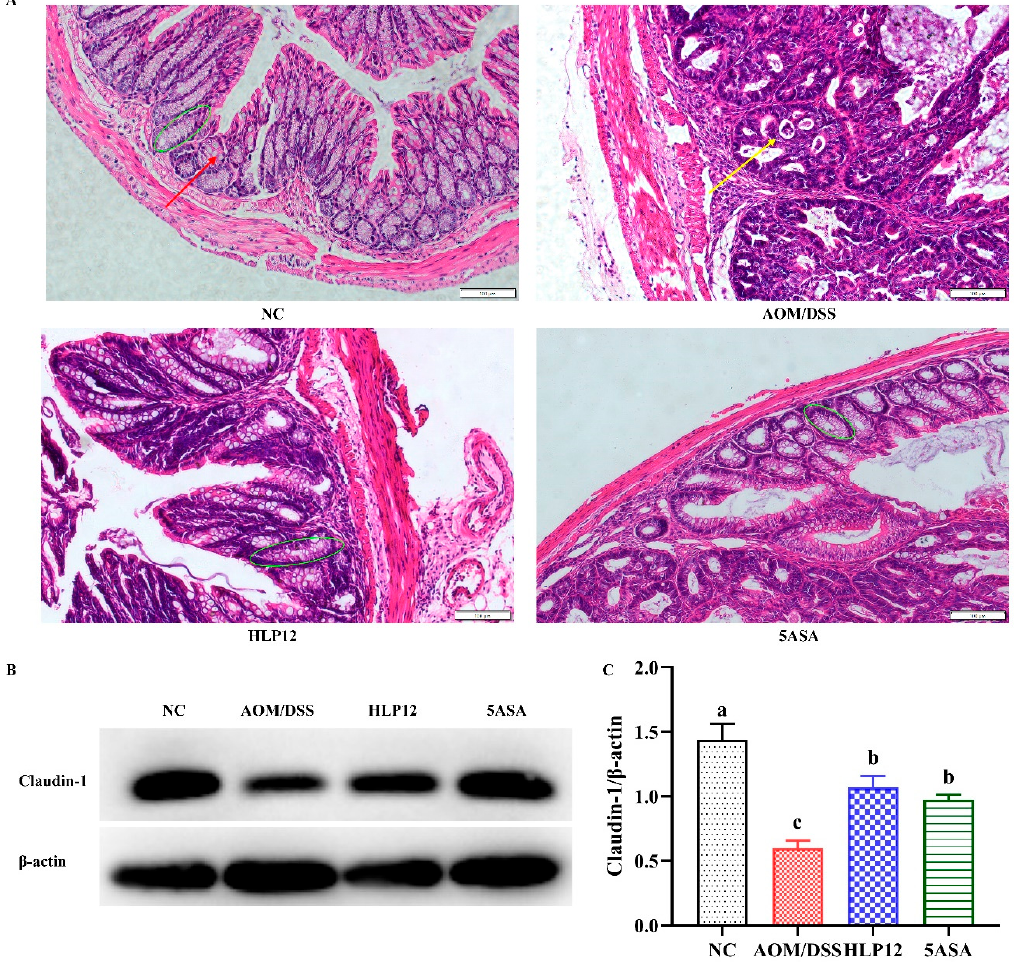
Figure 4. Effect of L. plantarum -12 oral administration on intestinal barrier function of the AOM/DSS- treated C57BL/6 mice. ( A ) Colon histological observation (Magnification: 200); the green oval represents the colonic crypt. The red arrow represents goblet cells. The yellow arrow represents adenomas. ( B ) The colon protein expression of Claudin-1 was determined by Western blotting, and ( C ) β -actin acted as control for the protein blots ( n = 4). The data with different lowercase letters are significantly different ( p < 0.05).